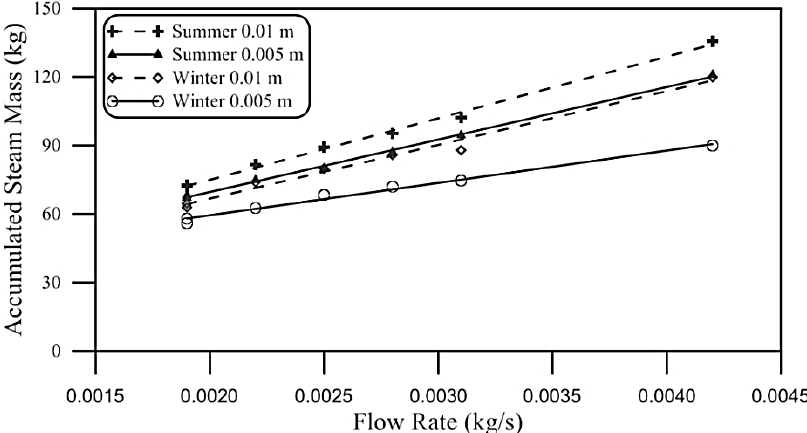
Figure 14. Accumulated steam mass over the day for the 0.005 m and 0.01 m tubes in winter and summer,